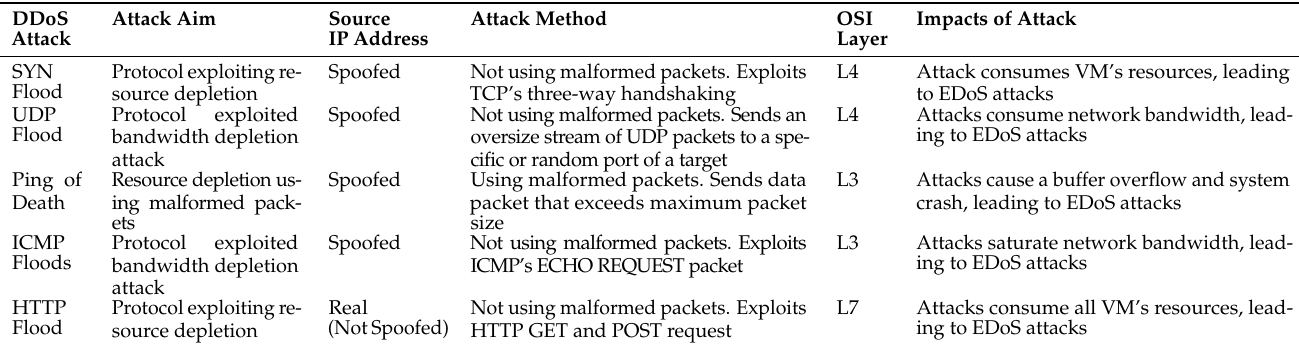
Table 5. DDoS attacks on CC.